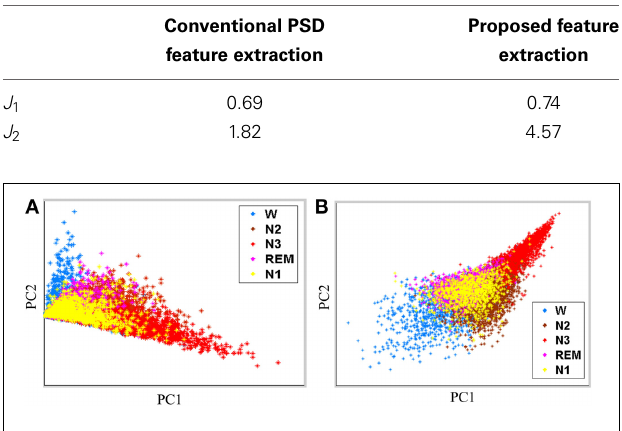
FIGURE 4 | Feature scatter plots with first two principal components (PCs) by (A) the conventional PSD feature extraction, and (B) the proposed feature